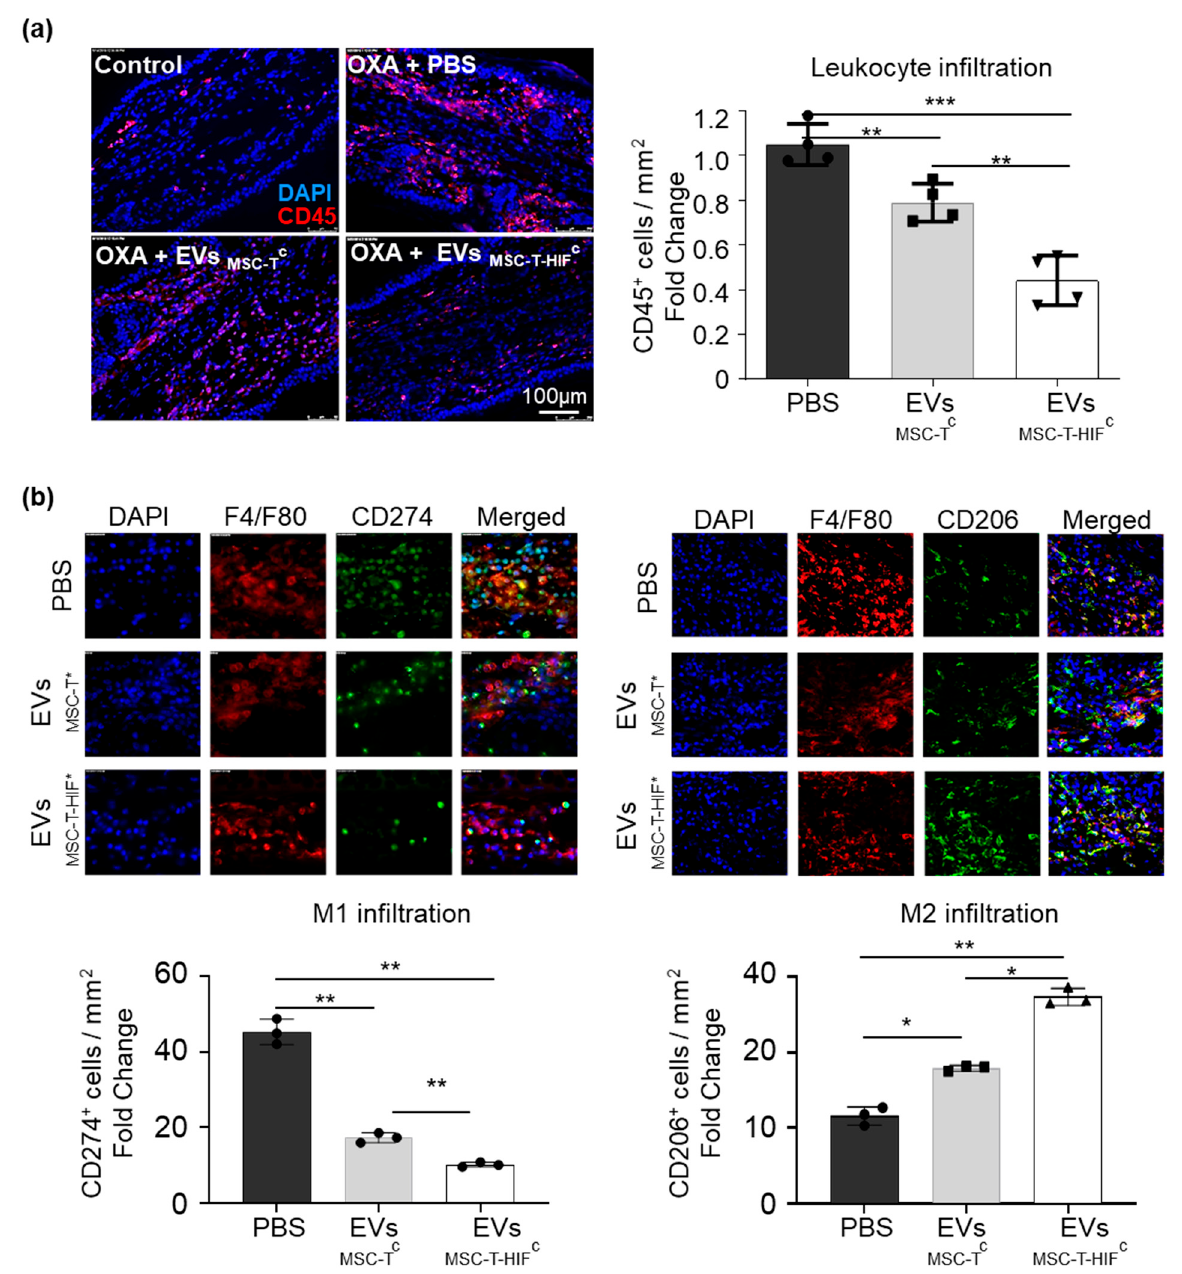
Figure 6. EV MSC-T-HIFc reduce leucocyte infiltration and the presence of immunomodulatory (M2) macrophages in a delayed- type hypersensitivity (DTH) mouse model. ( a ) Immunodetection of CD45+ cells in ears at the 72 h time point. Scale bar: 100 μ m. Quantification of CD45+ positive cells per mm 2 . ( b ) Immunodetection of F4/F80 (pan-macrophage marker; red) and CD274+ cells (pro-inflammatory (M1) macrophage; green) and CD206 (M2 macrophage; green) in ears at the 72 h time point. Scale bar: 100 μ m. Quantification of double positive cells per mm 2 . Data are relative to the PBS condition. Graphs represent mean ± SD of four mice. Paired t -test was used for statistics. * p < 0.05, ** p < 0.01, *** p < 0.001.